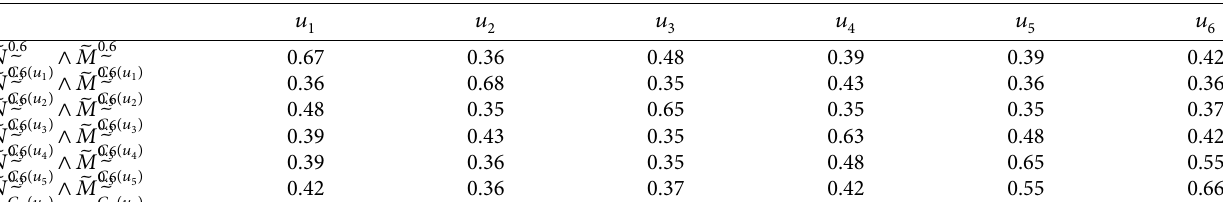
∧ 􏽥 M 0 . 6 􏽥 . C 3 ( u i ) C 3 ( u i )